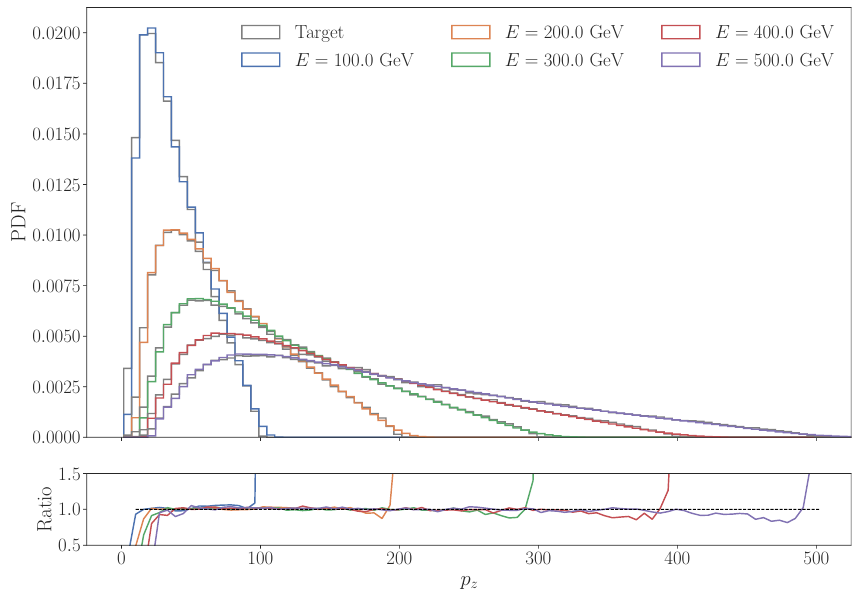
Figure 10: ML HAD generated p distributions using the cSWAE model trained on data z with string energies different from training and compared with P YTHIA